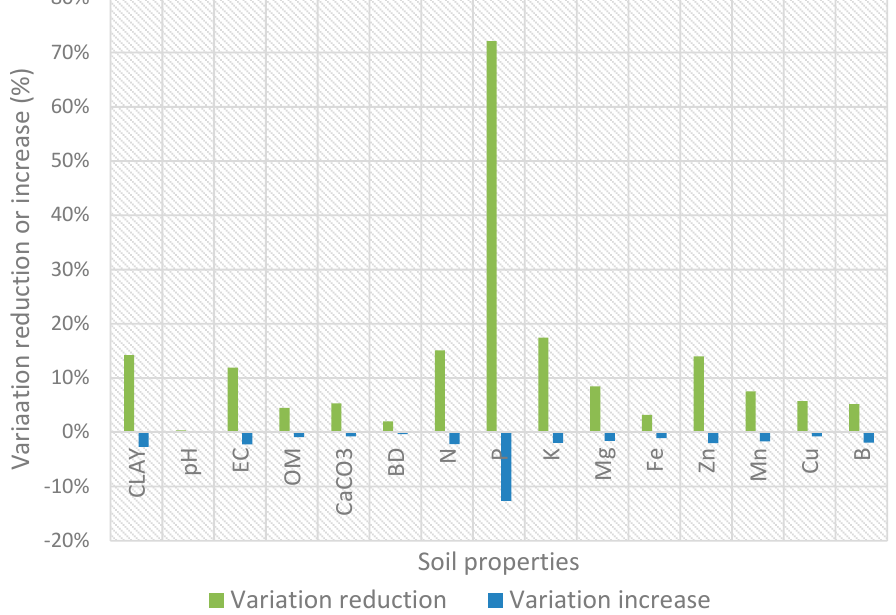
Figure 12. Plot of variation reduction or increase for soil properties after the rescaling